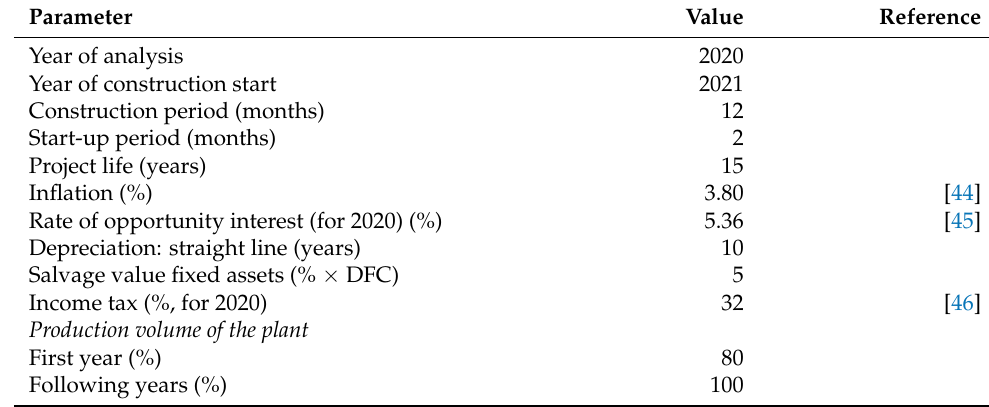
Table 2. Parameters used in the techno-economic assessment of the simulated process flowsheets. Parameter Value Reference Year of